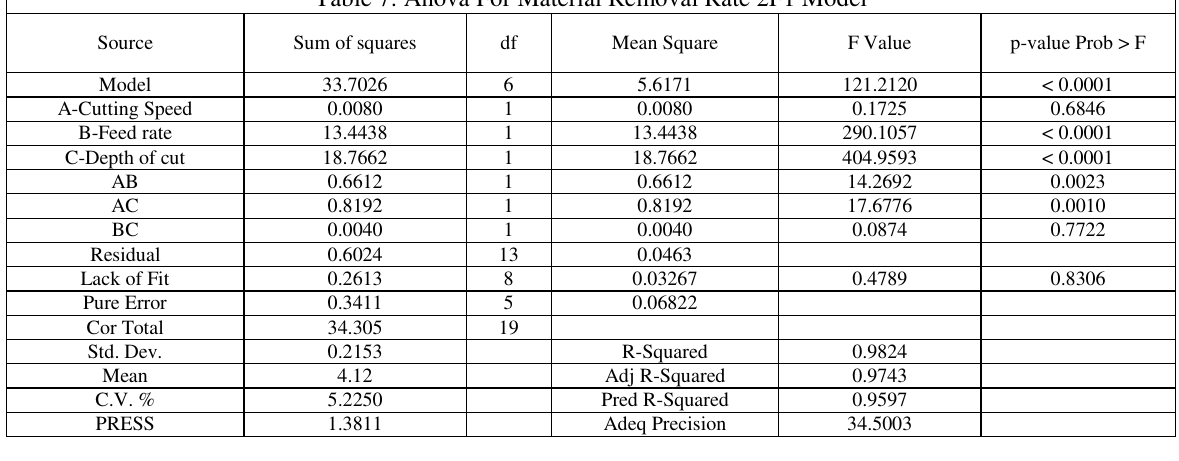
Table 7: Anova For Material Removal Rate 2F1 Model